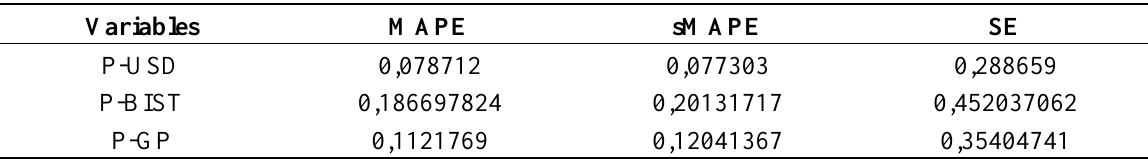
Table 3. Some symmetry measures after the financial crisis with the results of the second ANN output variables.